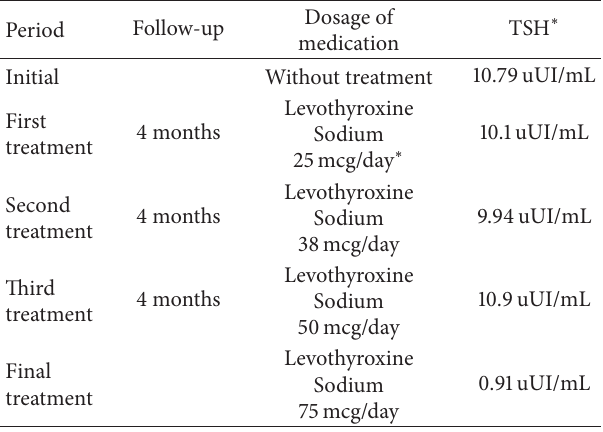
Table1:Follow-upoflaboratorialtestingresultsrelatedtotreatment